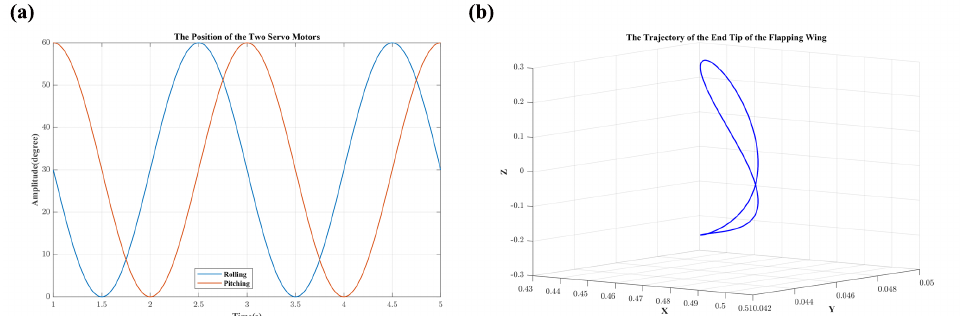
Figure 8. The trajectory of the flapping wing. ( a ) The position of the two servo motors. ( b ) The trajectory of the end tip of the flapping wing.